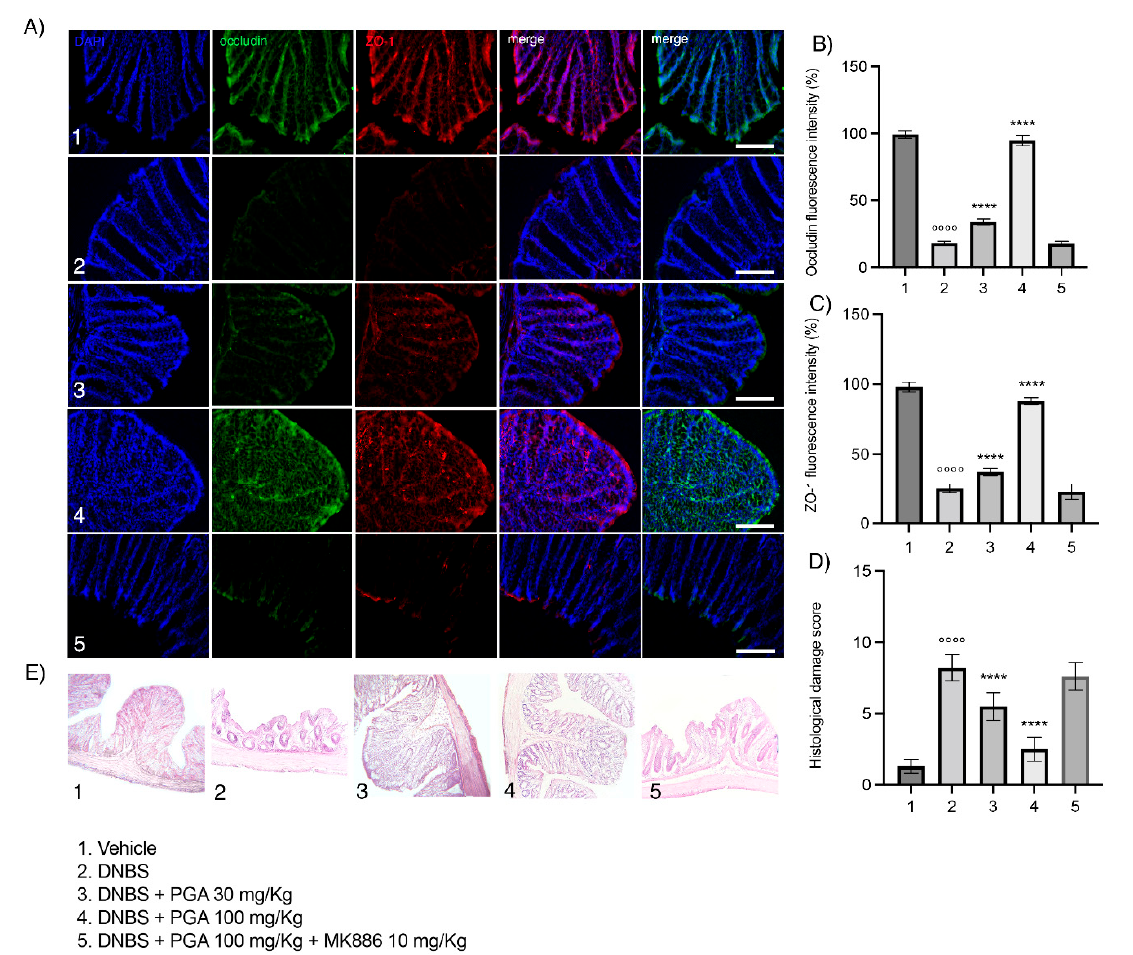
Figure 2. Micronized PGA prevents the loss of tight junction proteins ZO-1 and occludin, and colonic barrier disruption through PPAR- α involvement. ( A ) Representative images show double-label immunohistochemistry for occludin (green) and ZO-1 (red) in the colon with ( B , C ) relative quantification. Nuclei were also labeled by DAPI. ( E ) Representative images of H&E-stained on distal colon sections, and ( D ) relative histological damage score. Results are expressed as the mean ± SD of n = 5 experiments (25 slices for each animal). ◦◦◦◦ p < 0.0001 vs. vehicle; **** p < 0.0001 vs. DNBS. Scale bar = 100 µ m; magnification 20 × . Zonula occludens (ZO-1); peroxisome proliferator-activated receptors- α (PPAR- α ); hematoxylin and eosin (H&E), 2,4-dinitrobenzene sulfonic acid (DNBS).